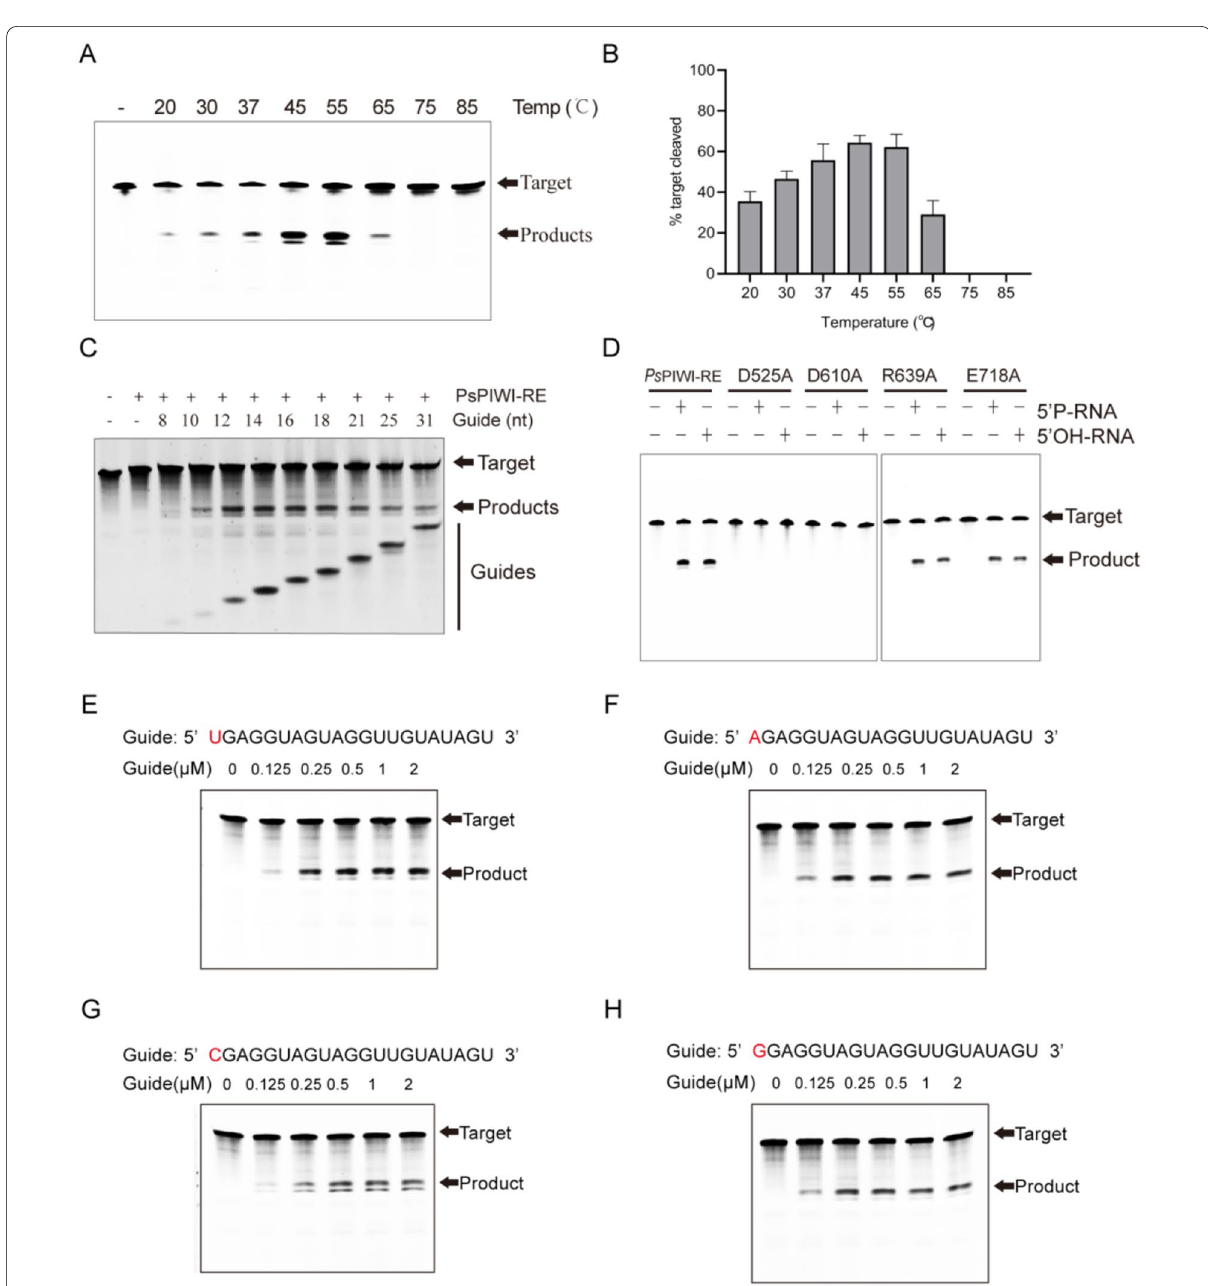
Fig. 3 Effect of a range of reaction conditions on RNA-guided DNA cleavage activity of Ps PIWI-RE. A Temperature dependence of the DNA target cleavage reaction with a 5 ′ phosphorylated (5 ′ P) RNA guide. “–”: without Ps PIWI-RE. B Quantitative analysis of the cleavage efficiency of Ps PIWI-RE at different temperatures. Histogram were plotted from triplicate data. Mean values SD are shown, n 3. C Dependence of the efficiency of DNA ± = cleavage on the length of guide RNA. D DNA cleavage assays of Ps PIWI-RE and mutants. Ps PIWI-RE was loaded with a 21 nt guide RNA and was incubated with a 78 nt single stranded DNA (ssDNA) target in a 25:5:1 molar ratio (protein:guide:target). The target cleavage took place at 37 °C for 4 h with 10 mM Mg 2 + . Products were resolved on a 16% denaturing polyacrylamide gel. E – H Effect of the variation of the 5 ′ end nucleoside of the guide RNA on Ps PIWI-RE cleavage efficiency. 0–2 μM of 21 nt RNA guides containing a different 5 ′ end nucleoside were incubated with Ps PIWI-RE, followed by 78 nt target DNA. The 5 ′ nucleoside modifications were as follows: 5 ′ phosphorylated (5 ′ P) DNA, 5 ′ hydroxyl (5 ′ OH) DNA, 5 ′ phosphorylated (5 ′ P) RNA, and 5 ′ hydroxyl (5 ′ OH) RNA. Products of the reactions were resolved on denaturing polyacrylamide